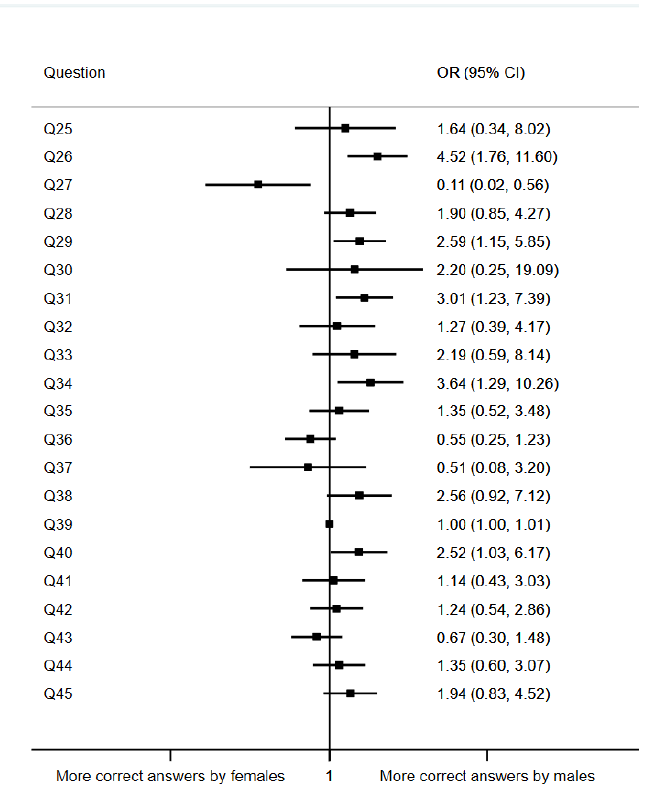
Figure 2. Association between questions regarding students’ opinions and sex (ref. female).